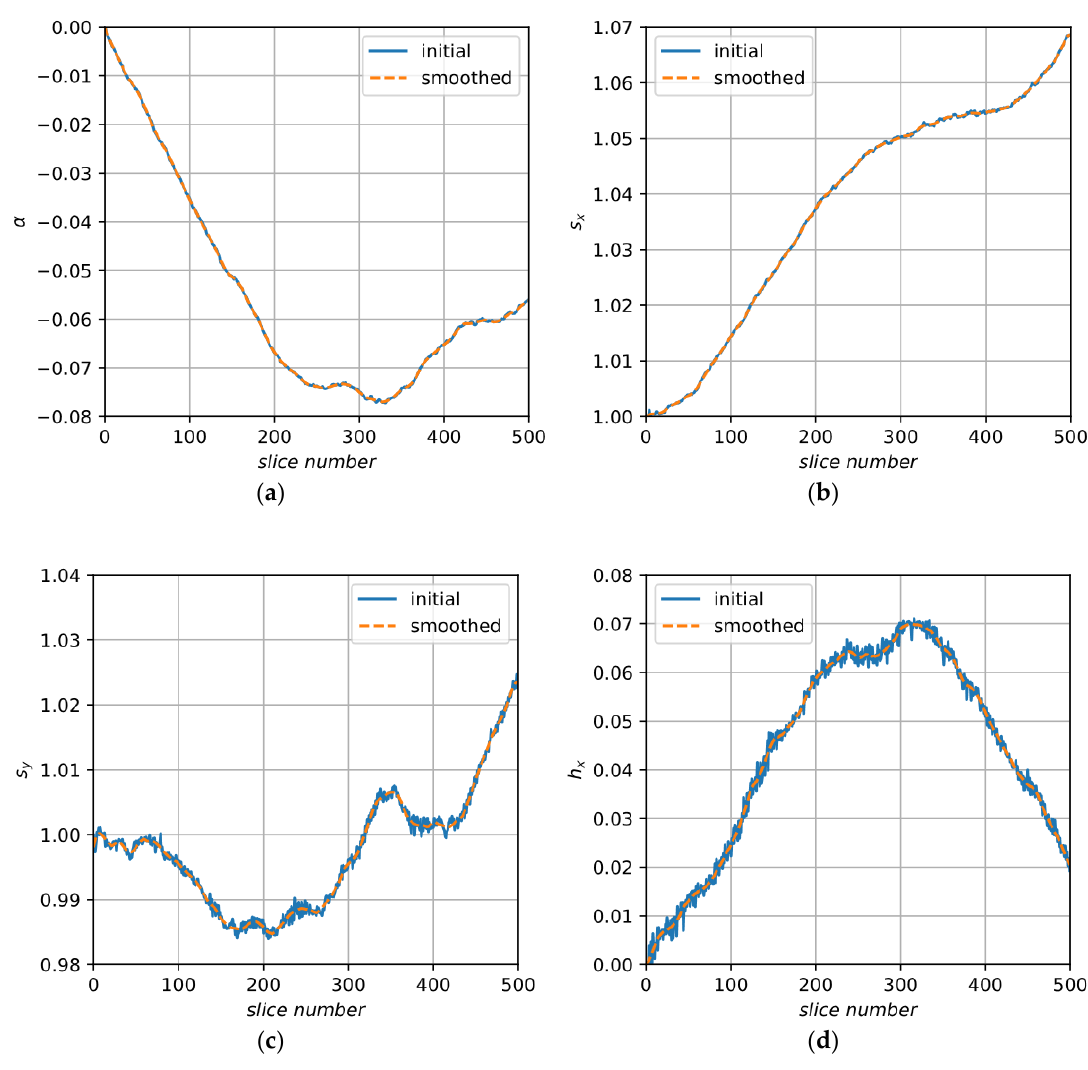
Figure 8. Initial and smoothed elements of decomposition for sample A: ( a ) angle α ; ( b ) stretch factor along the X axis, s x ; ( c ) stretch factor along the Y axis, s y ; ( d ) factor of shear along the X axis, h x .